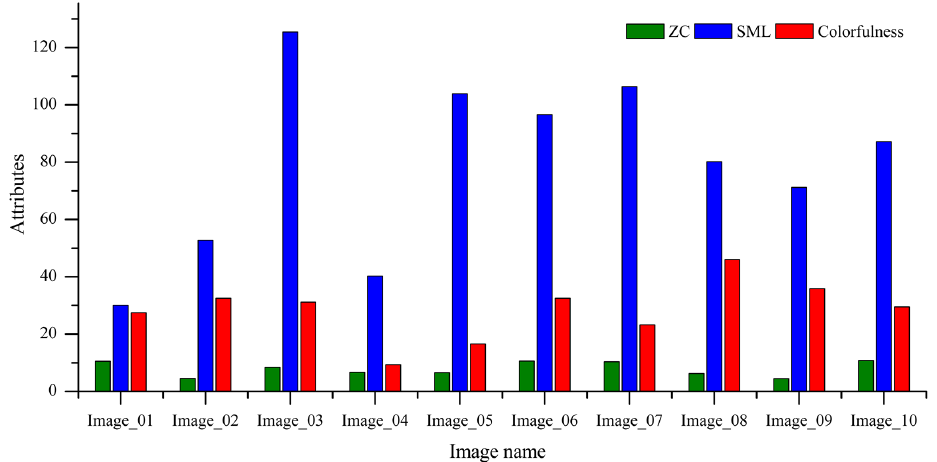
Figure 4. Image quality attributes ZC, SML, and Colorfulness of the test images.